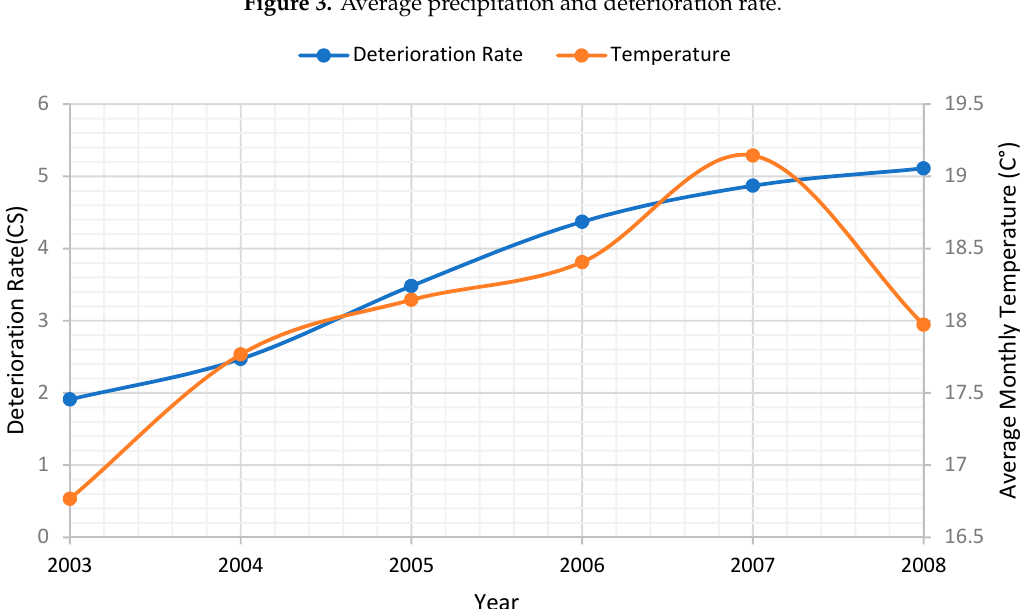
Figure 4. Average temperature and deterioration rate